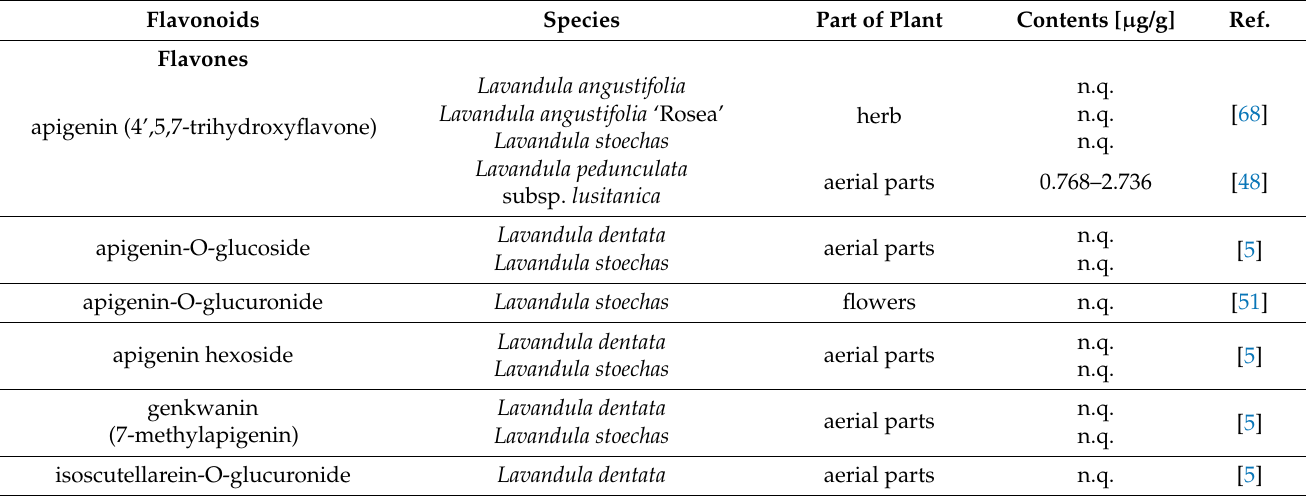
Table 4. Flavonoids in different species of